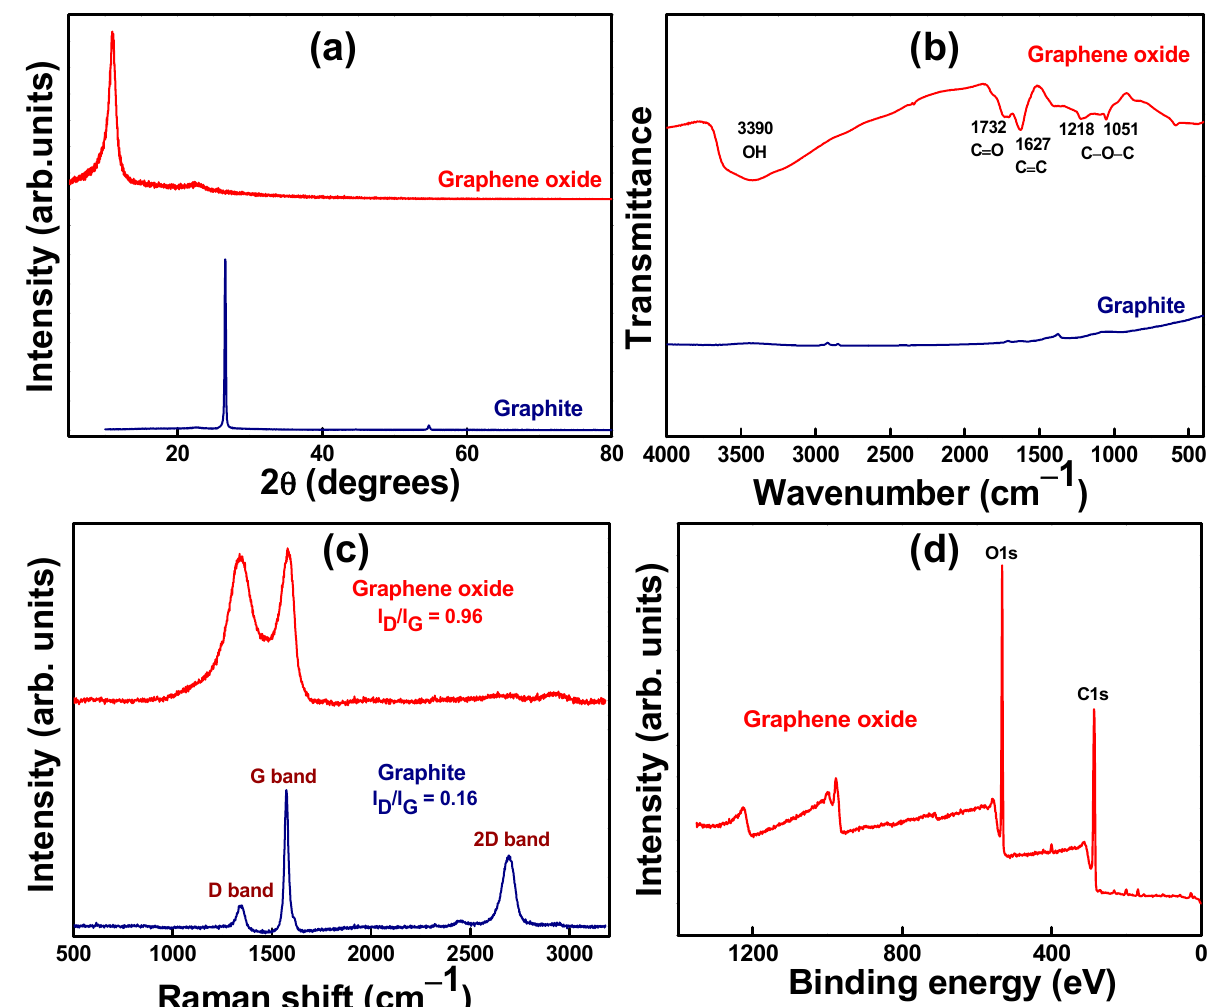
Figure 3. ( a ) X-ray diffraction patterns, ( b ) Fourier transform infrared spectra, ( c ) Raman spectra of graphite and graphene oxide, and ( d ) full scan X-ray photoelectron spectrum of graphene